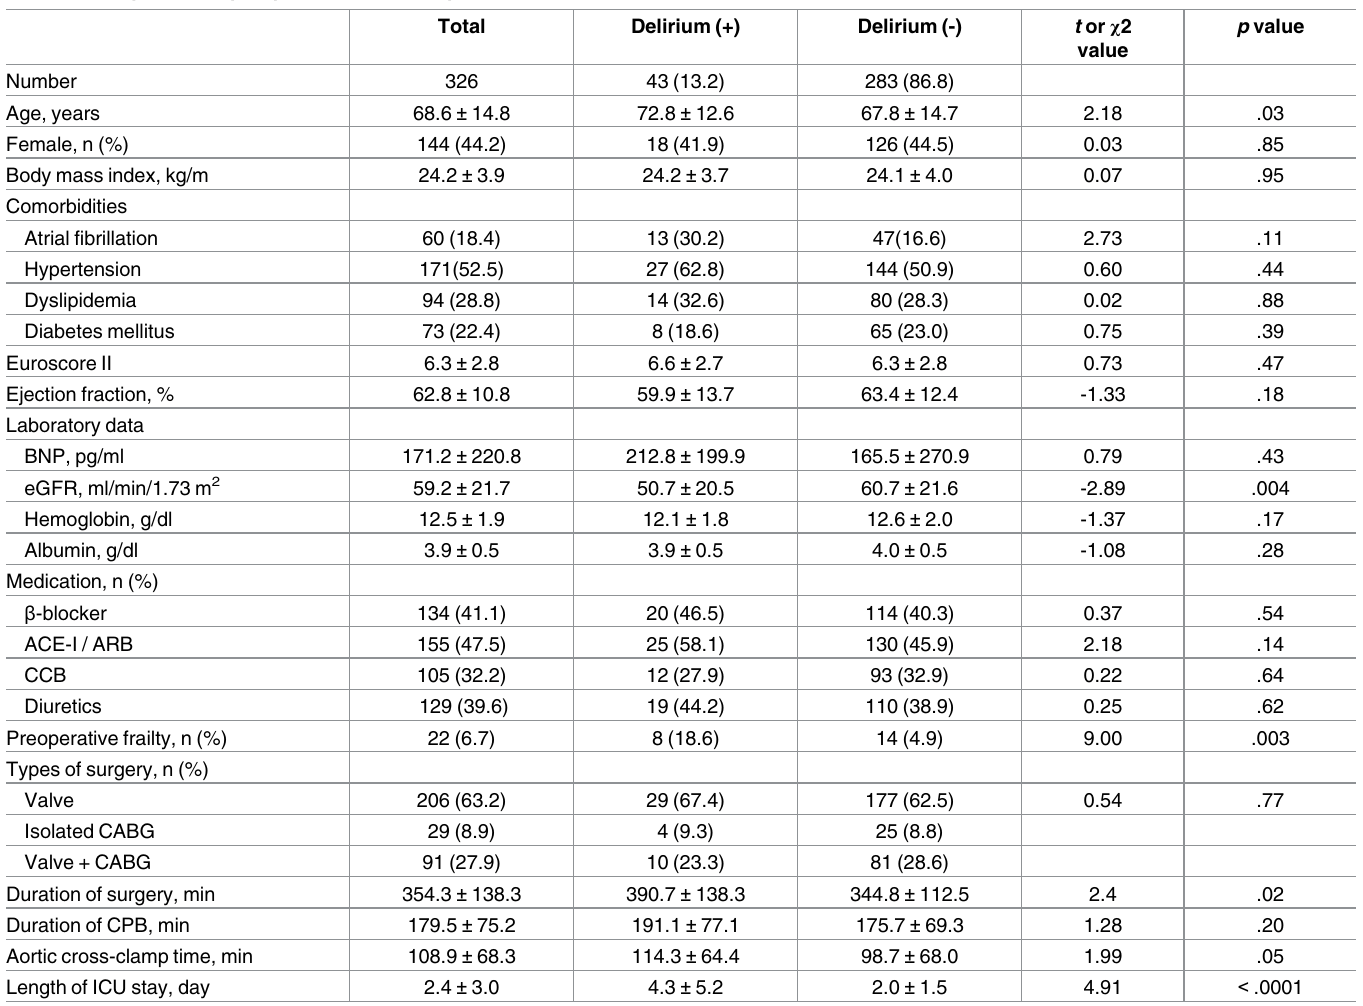
Table 2. Comparison of preoperative and intraoperative risk factors for delirium.